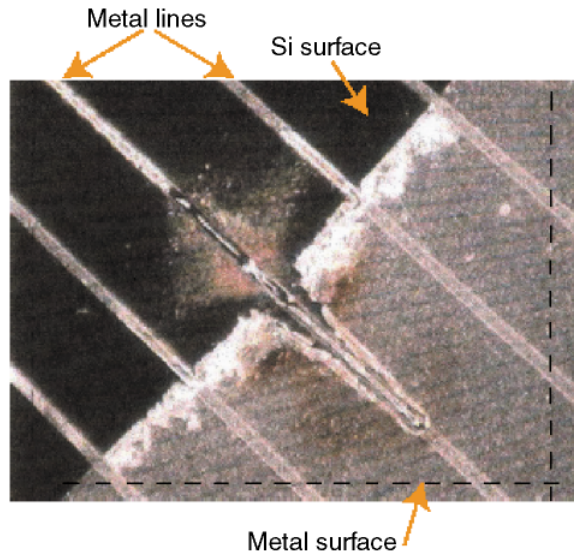
FIG. 23. Lines burned by biasing currents.